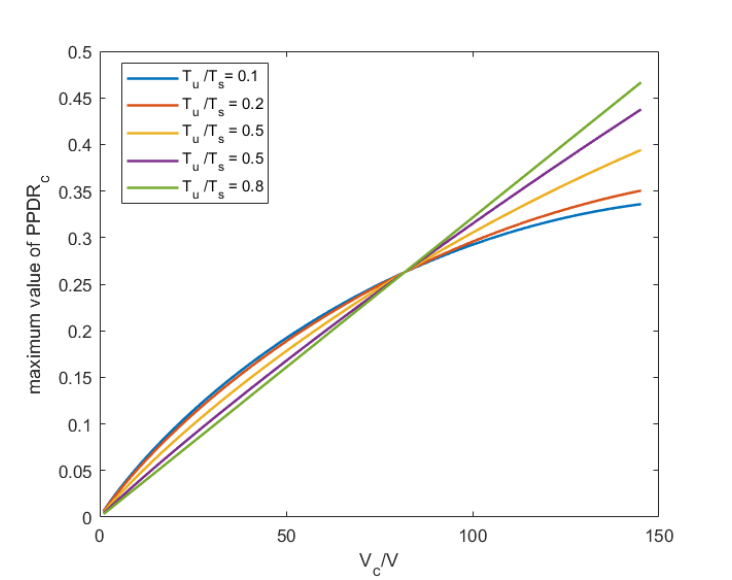
Figure 7. Influence of V c and T u / T s on the maximum value of PPDR c